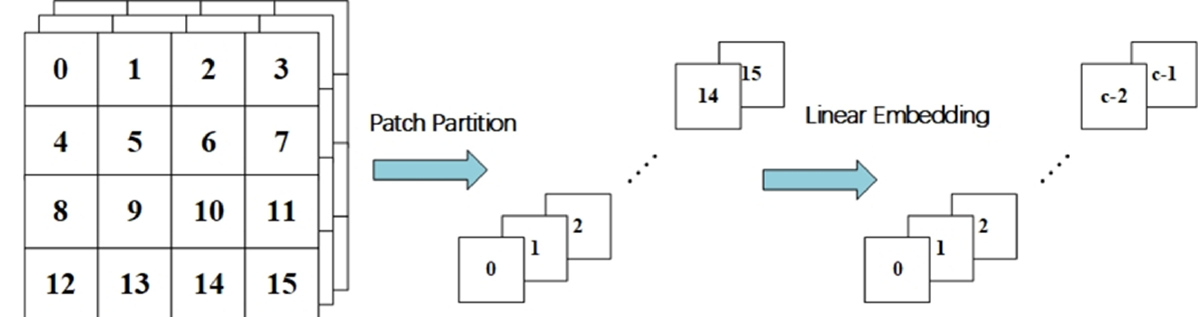
Figure 8. Patch Embedding module.